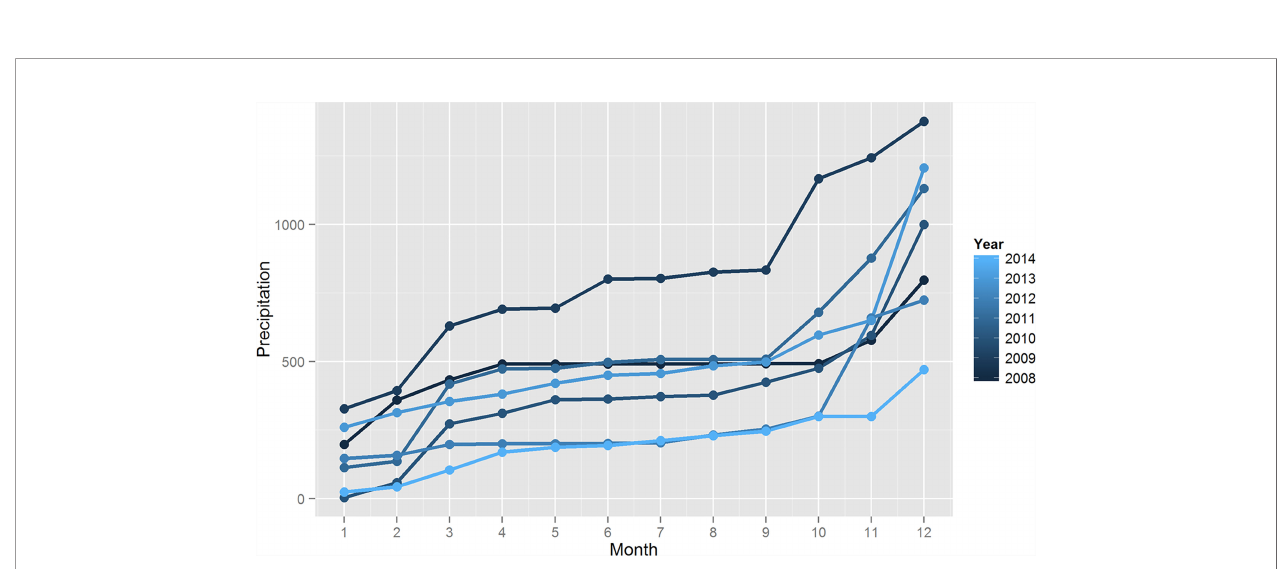
FIGURE 6 | Precipitation data in the city of Governador Valadares. Inset shows cumulative precipitation in Governador Valadares since 2008 to 2014. Analysis of the data suggest a signi fi cant decrease in rainfall during 2014.